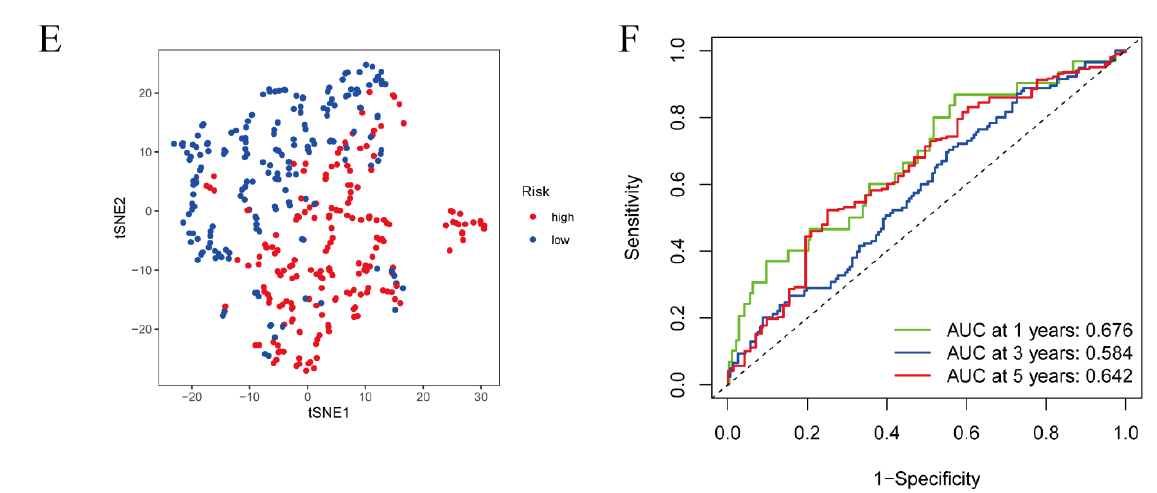
Figure 3. Construction of a prognostic signature in the TCGA cohort. (A ) Distribution of the risk score in the TCGA cohort. ( B ) Kaplan–Meier survival curve for OS of ovarian cancer in the TCGA cohort. ( C ) Distribution of survival status and risk score of each patient. ( D ) PCA plot of the TCGA cohort by 5 genes. ( E ) t-SNE analysis in the TCGA cohort by 5 genes. ( F ) ROC curve demonstrating the predictive efficiency of the 5-gene prognostic signature in the TCGA cohort.